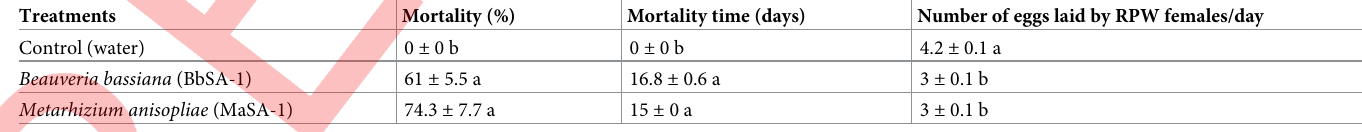
Table 5. Mean mortality (% ± SE) of adults of red palm weevil treated with Metarhizium anisopliae and Beauveria bassiana under laboratory conditions. Treatments Mortality (%) Mortality time (days) Number of eggs laid by RPW females/day Control (water) Beauveria bassiana (BbSA-1) Metarhizium anisopliae (MaSA-1) Means followed by the same letter in the same column are not significant different at α :